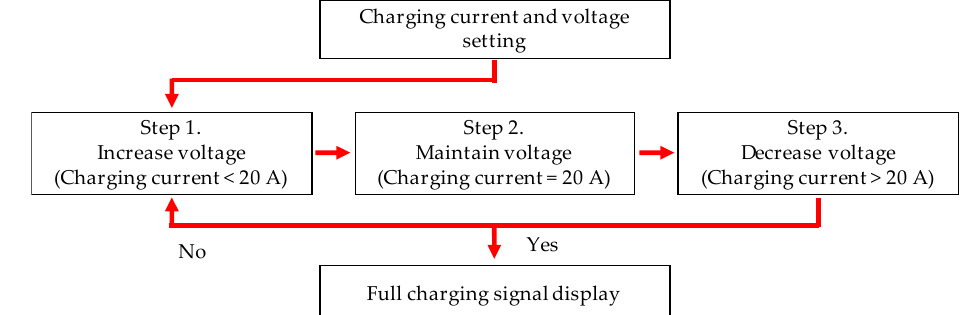
Figure 2. Integrated control system for the H-EMCS.